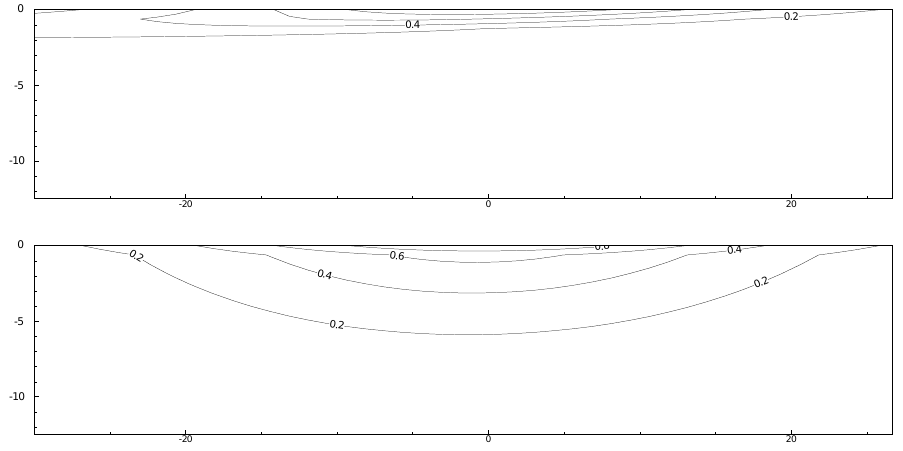
Figure 11. Contours of dimensionless excess pore-water pressure for different value of Young’s modulus (From top to bottom, E = 1.0 × 10 4 and 1.0 × 10 7 kPa); k = 1.0 × 10 − 4 m/s.